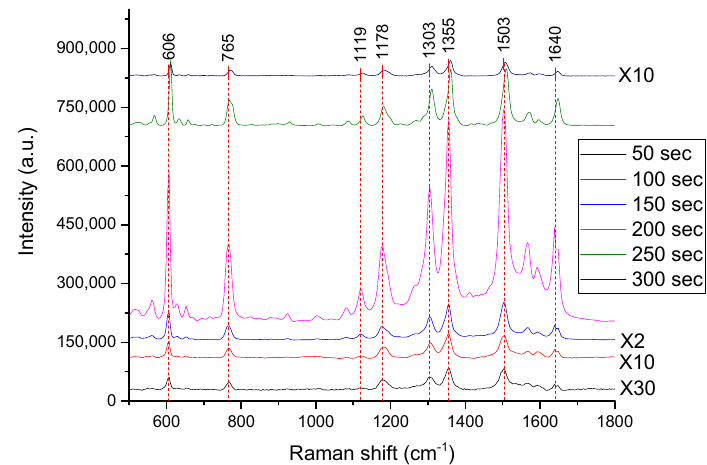
Figure 7 . The SERS spectra of the R6G molecules on the developed SERS active substrate with sputtering durations of 50, 100, 150, 200, 250 and 300 s, respectively.